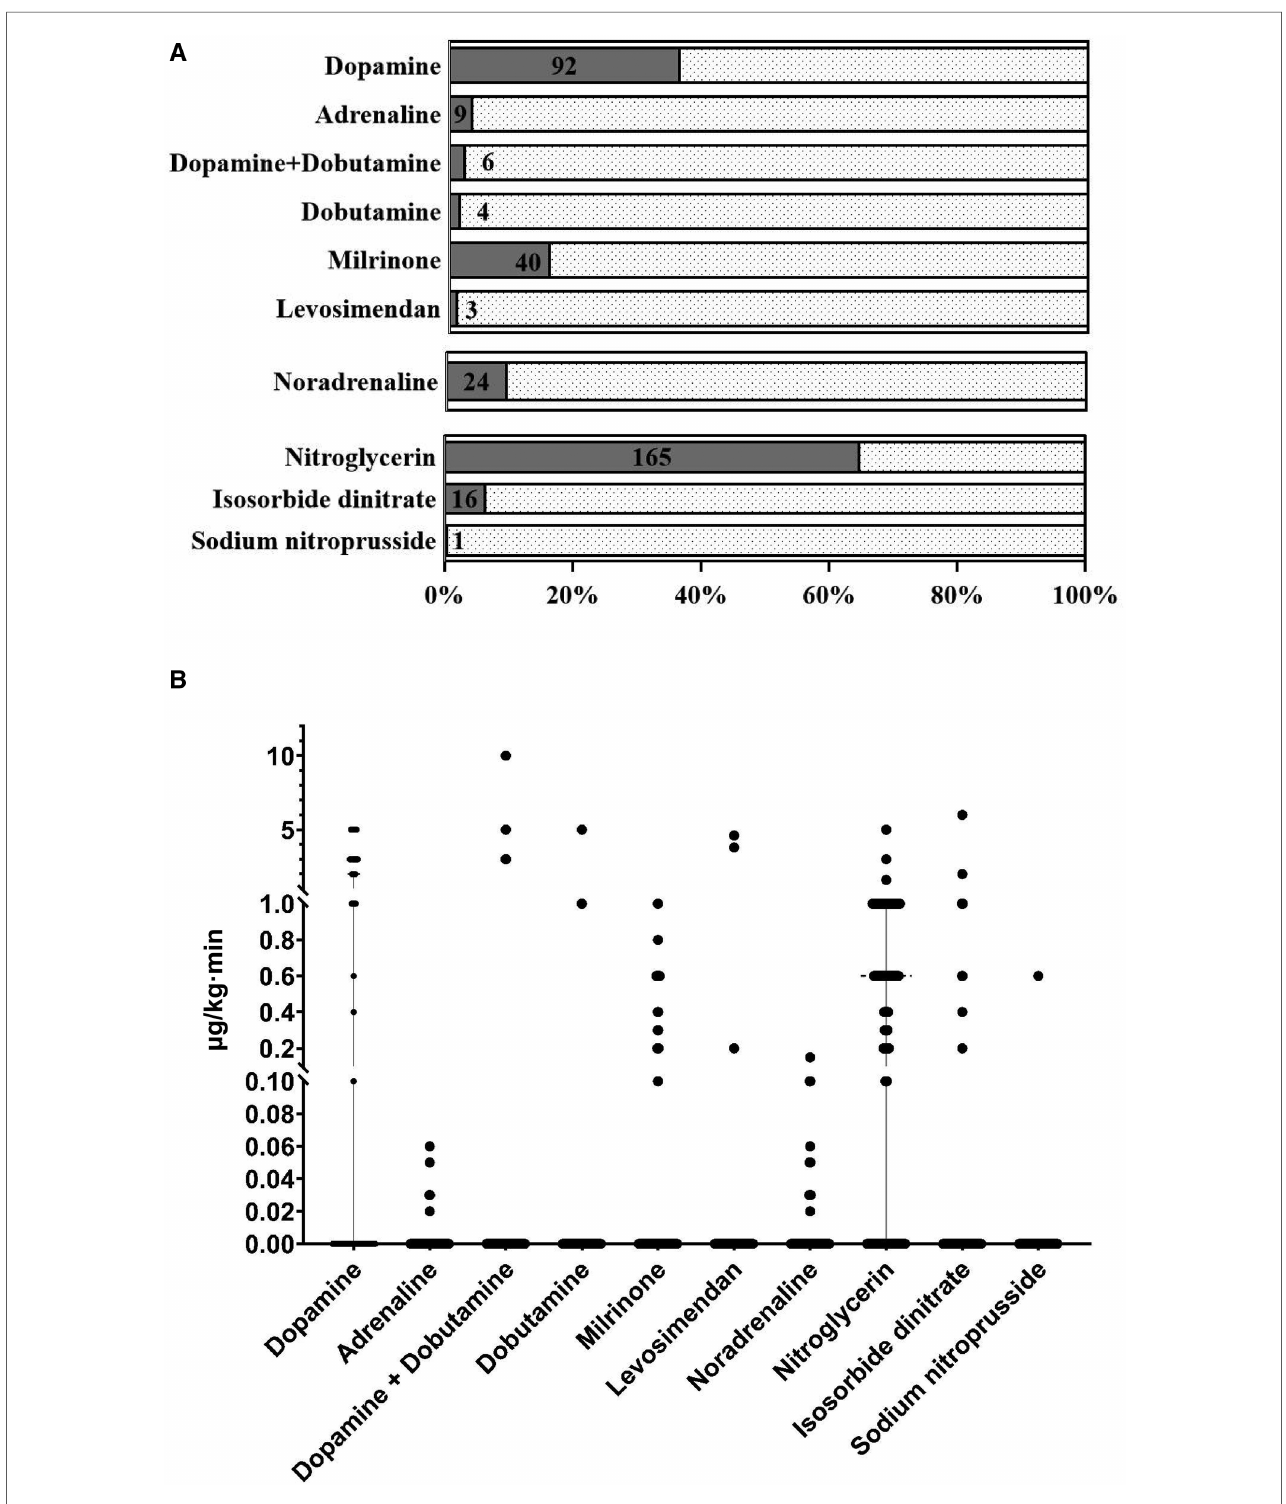
FIGURE 5 ( A ) The frequencies of the inotropic and vasoactive agents usages (continuous infusion) at the end of the surgery. Nitroglycerin (165/255, 64.7%) and dopamine (92/255, 36.1%) were the most frequent vasoactive agents with a fashion of continuous infusion. ( B ) The individual dosages of inotropic and vasoactive agents were displayed in the scatter